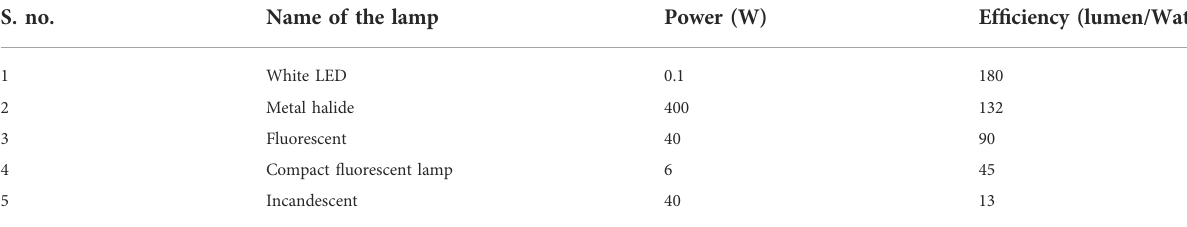
TABLE 1 Ef fi ciency of various